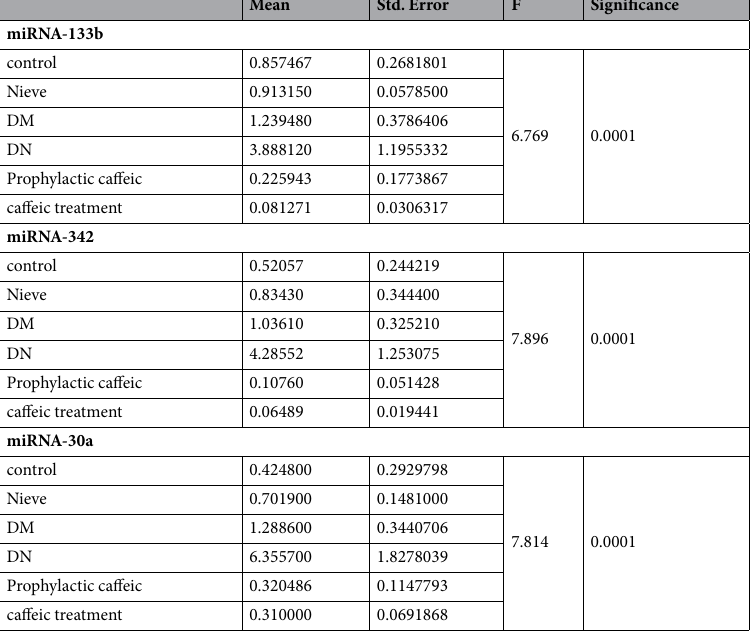
Table 3. miRNA Expression among different groups of animal model.